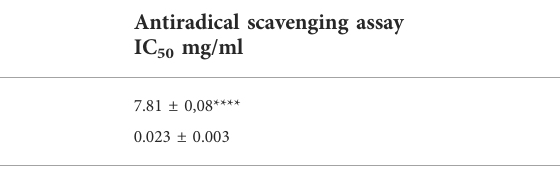
TABLE 2 In vitro antioxydant potential of N. sativa essential oil using DPPH a,d FRAP assays.